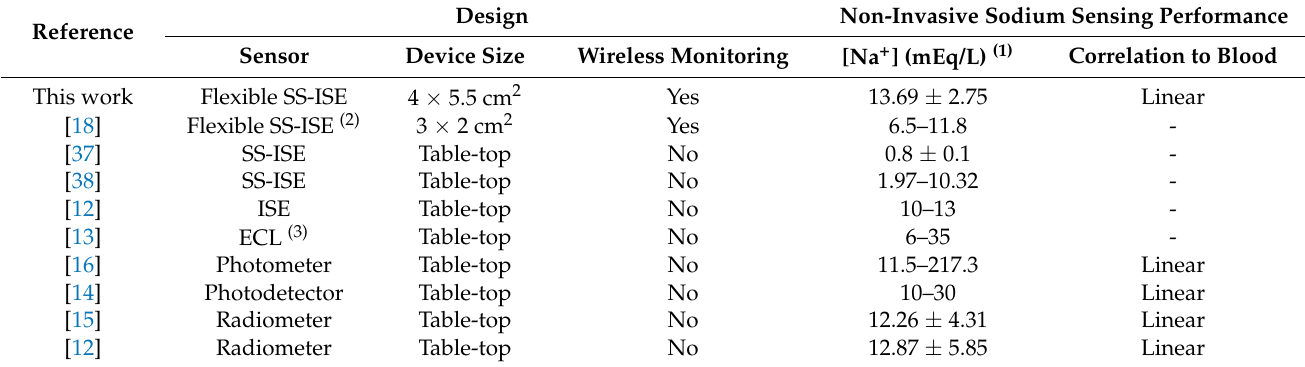
Table 1. Design comparison of non-invasive, salivary sodium detection system between this work and prior reports.